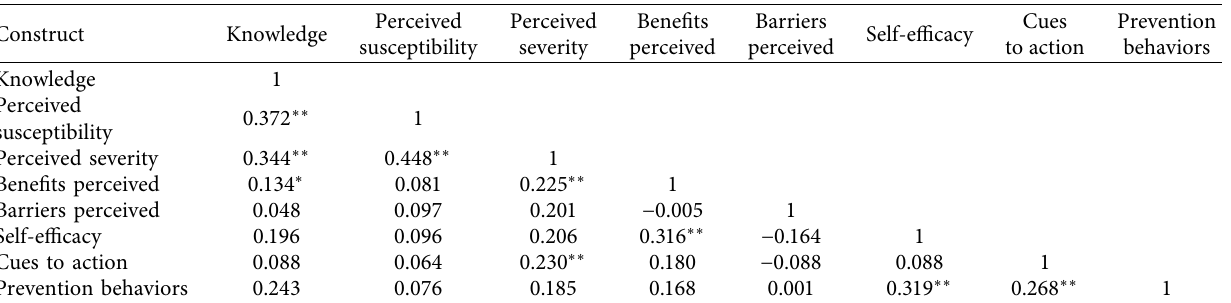
Table 2: Te correlation coefcient matrix of health belief model ( n � 289).